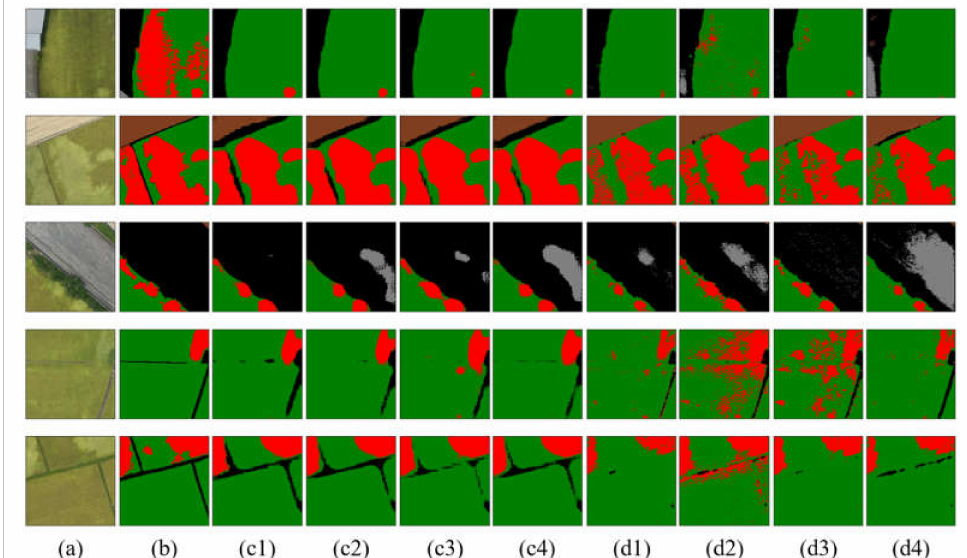
Figure 9. Rice lodging identification validation: ( a ) original image, ( b ) ground truth, ( c1–c4 ) represents FCN-AlexNet (RGB), (RGB + ExG), (RGB + ExGR), (RGB + ExG + ExGR), respectively. ( d1–d4 ) represents SegNet (RGB), (RGB + ExG), (RGB + ExGR), (RGB + ExG + ExGR),